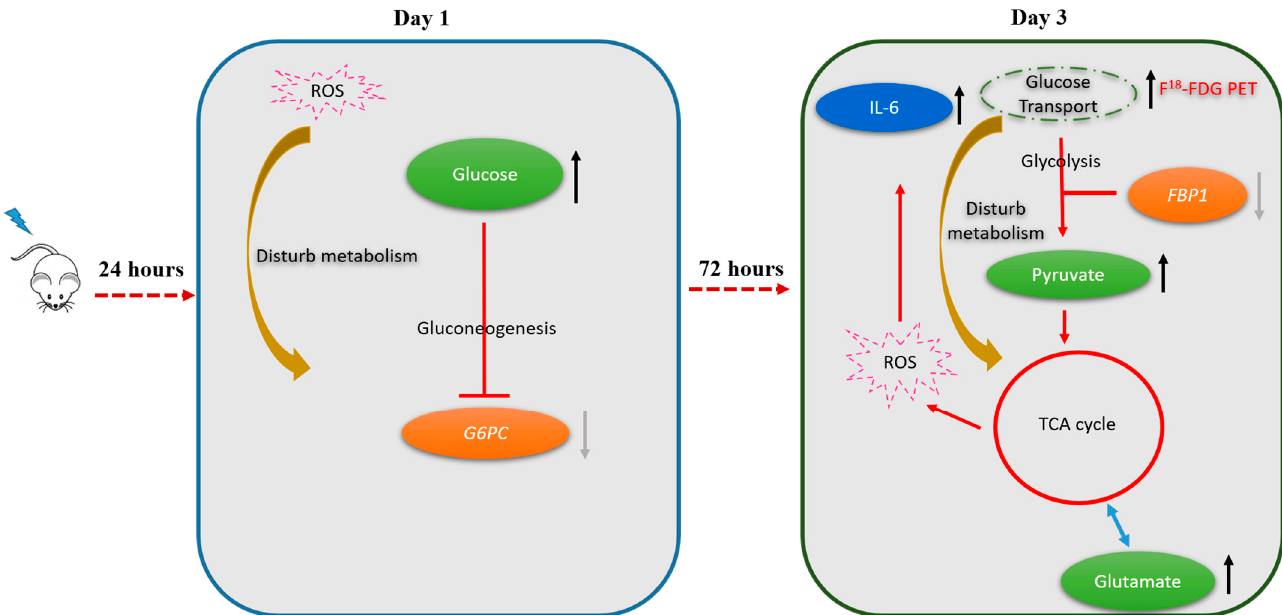
Figure 5. Shift in metabolic pathways from the first to the third post-irradiation day (right lobe of the liver). On the first post-irradiation day, radiation-induced production of reactive oxygen species (ROS) inhibited gluconeogenesis (as reflected by a reduced expression of the G6PC gene). On the third post-irradiation day, there was a shift towards glycolysis as reflected by a reduced expression of the FBP1 gene accompanied by an accumulation of pyruvate, glutamate, and the activation of the tricarboxylic acid cycle (TCA). The complex interplay between the activation of glycolysis and the presence of ROS also elicited an inflammatory response with an increased expression of IL-6. The metabolic shift occurring on day 3 can explain the significantly increased hepatic 18F-FDG uptake observed on 18F-FDG PET imaging at this time point.